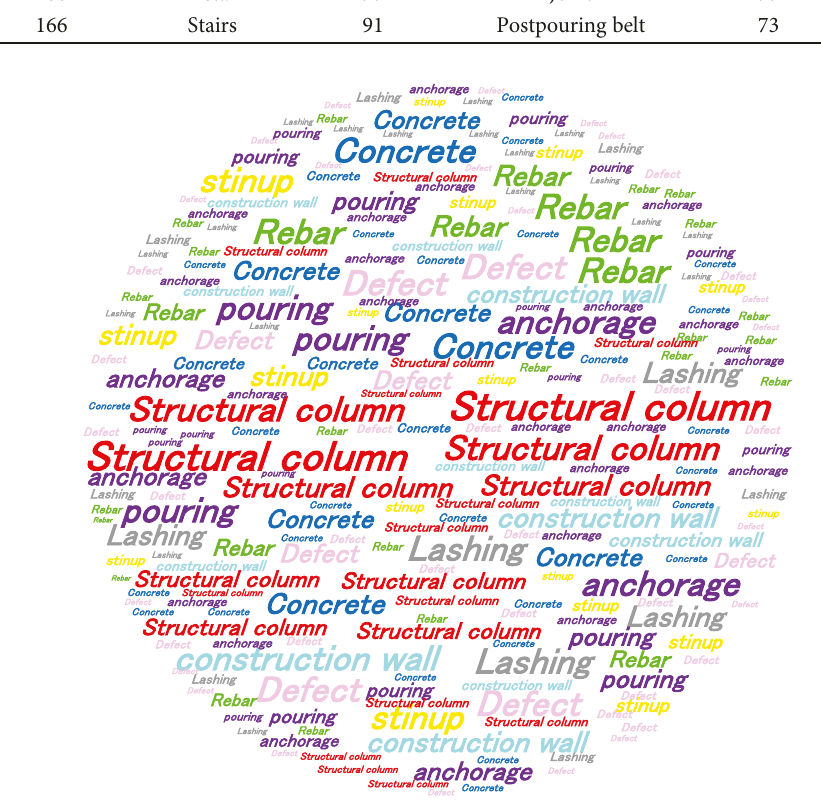
Figure 4: Textual nephogram of the quality problem of the main structure of the building